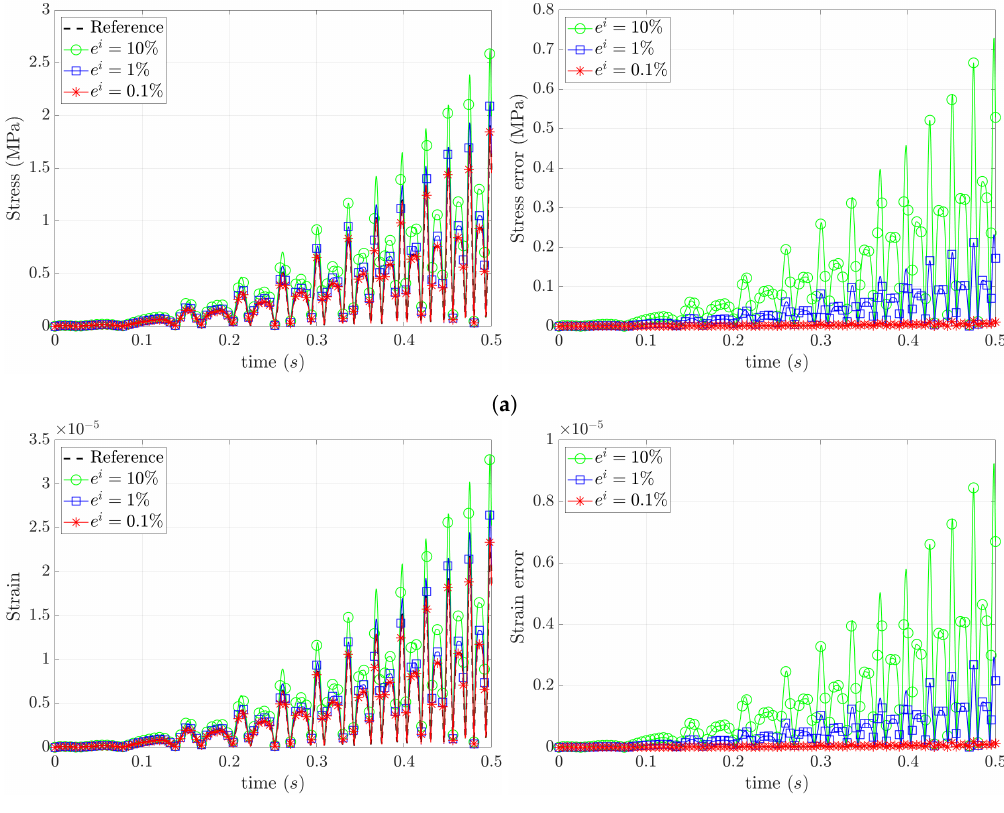
Figure 16. The von Mises stress and strain of node A for the different error tolerances e i = 10%, 1%, and 0.1% and their errors. ( a ) The von Mises stress of node A and its absolute error; ( b ) the von Mises strain of node A and its absolute error.